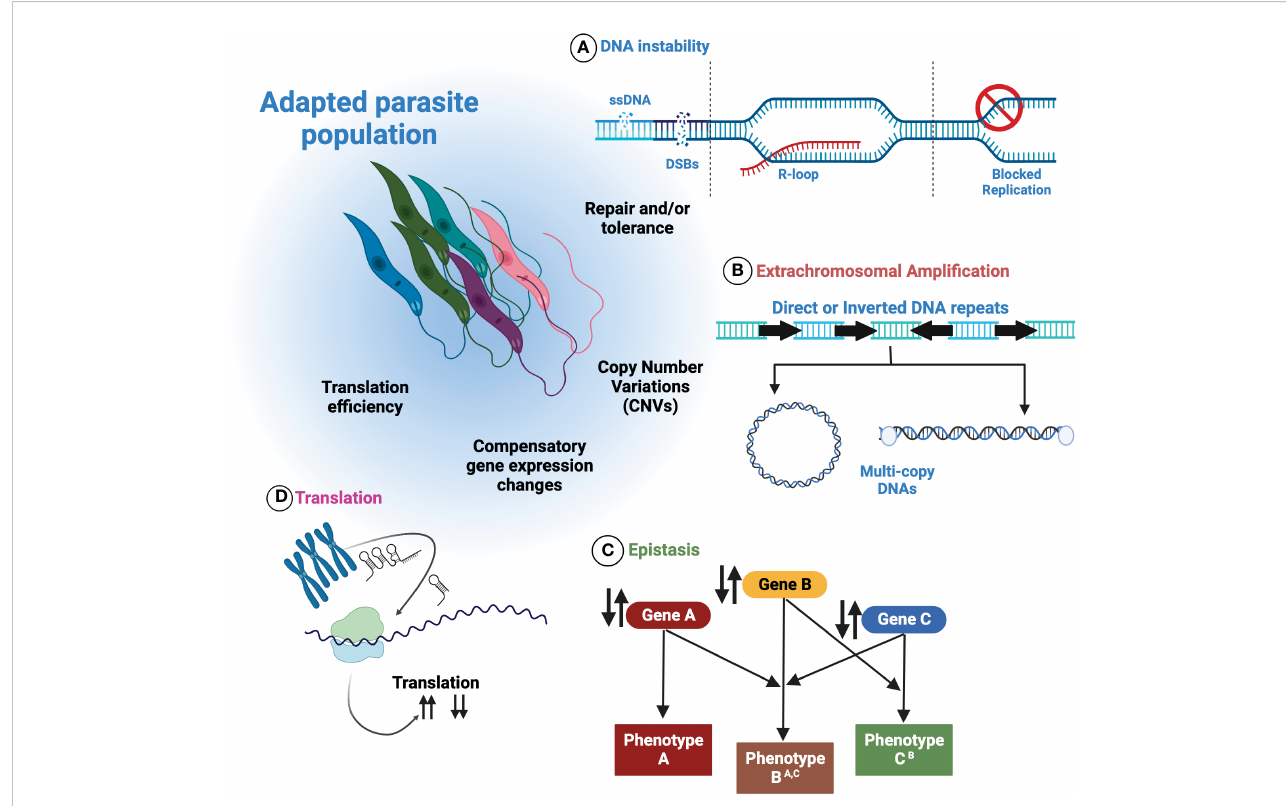
FIGURE 3 Control over genome plasticity in Leishmania is multifactorial. Numerous processes are thought to contribute to Leishmania genome plasticity. (A) Inherent DNA instability may be a key source of genome plasticity events in Leishmania . How these events are repaired and/or tolerated may offer deeper insights into how they are exploited by Leishmania . (B) By increasing or decreasing the abundance of extrachromosomal amplicons, Leishmania can modulate the corresponding mRNA levels in response to changing environments. (C) Epistatic interactions may operate in Leishmania , allowing compensatory mutations or genomic rearrangements to arise. (D) The putative regulation of translation by non-coding RNAs may permit the modulation of translation ef fi